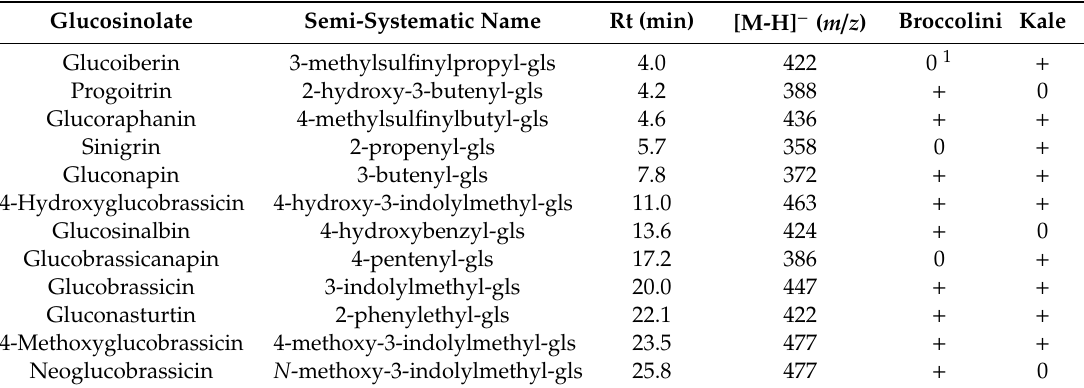
Table 1. List of glucosinolates detected in Brassica vegetables. Glucosinolate